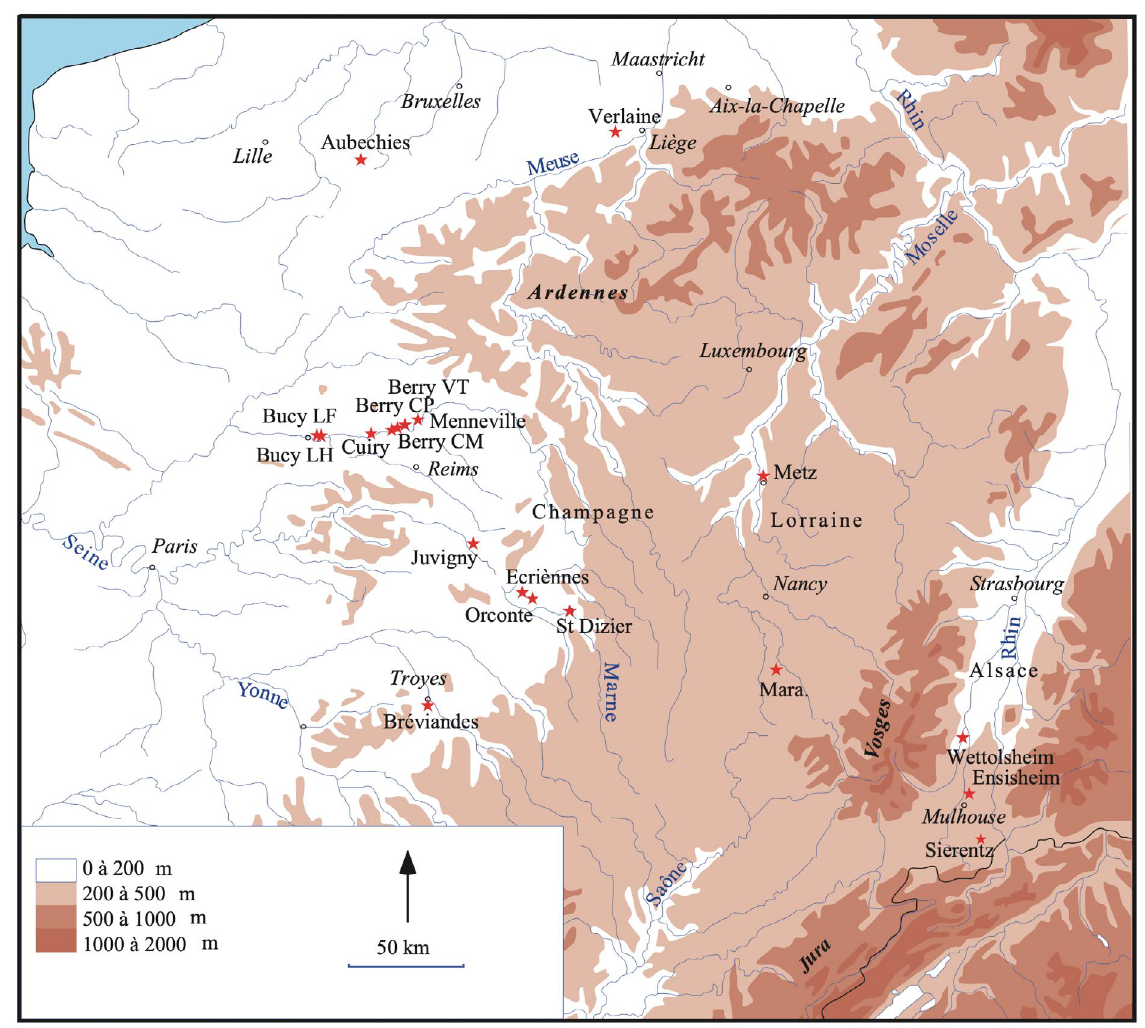
Figure 6. The main LPC sites mentioned in the